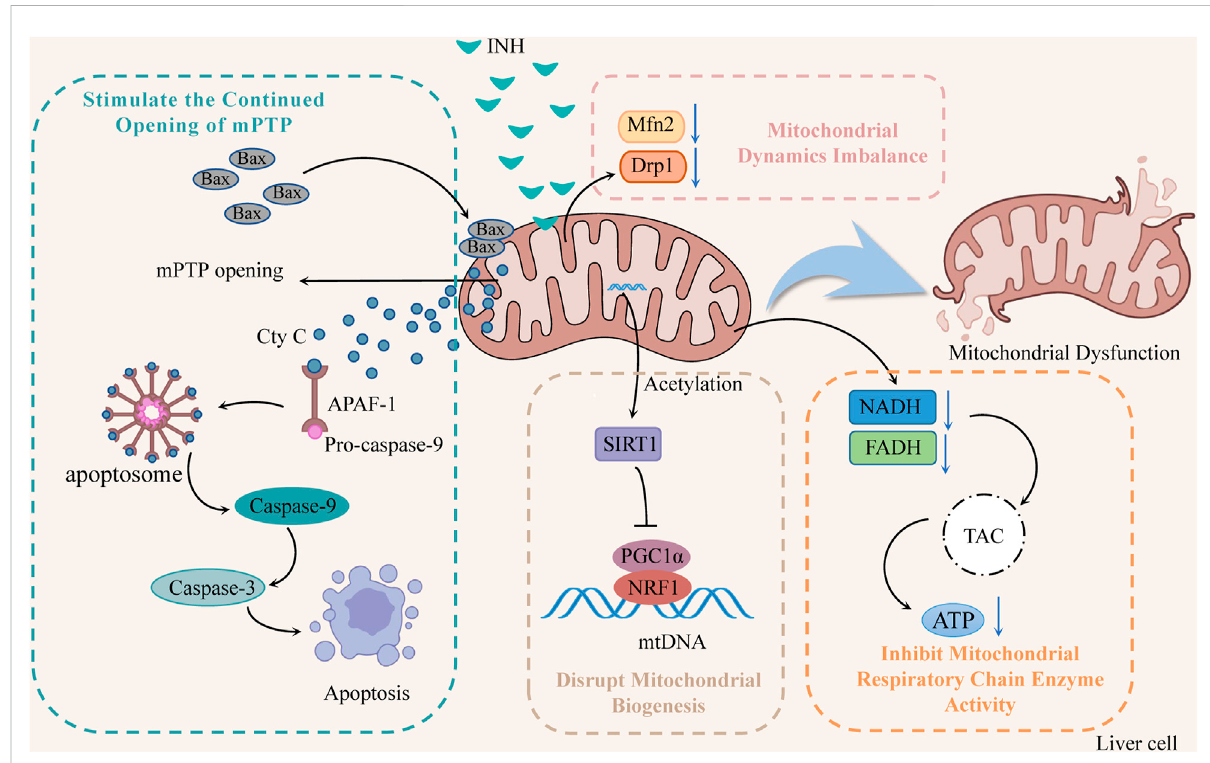
FIGURE 2 The mechanisms of INH-induced mitochondrial dysfunction (INH contributes to mitochondrial dysfunction by stimulating the continued opening of mPTP, disrupting mitochondrial biogenesis, inducing mitochondrial dynamics imbalance, and inhibiting mitochondrial respiratory chain enzyme activity). Notes: mPTP, mitochondrion permeability transition pore; Cyt C, cytochrome C; APAF-1, apoptotic protease activating